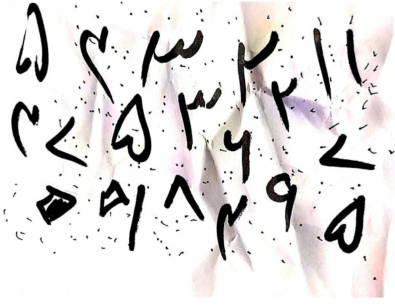
Figure 4. Actual crumbled